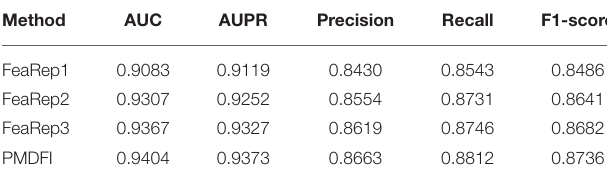
TABLE 4 | The specific outcomes based on different feature representation methods.